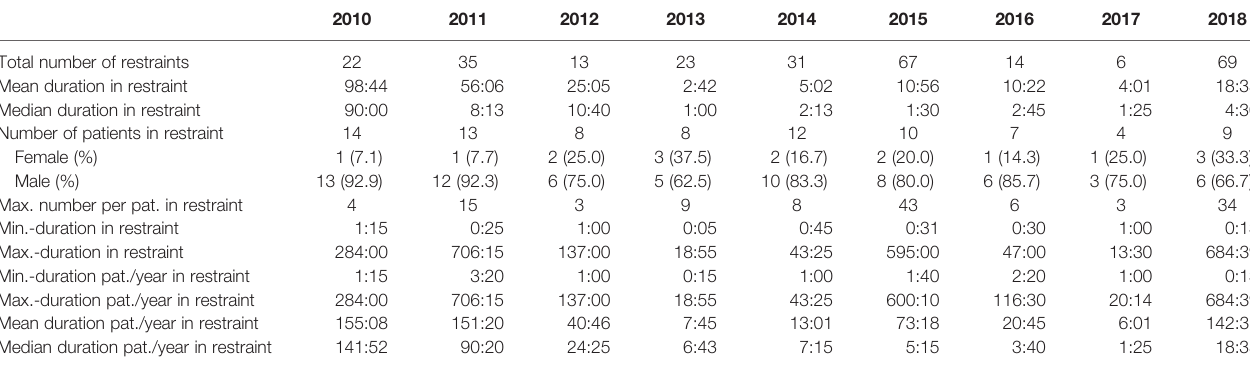
Durations are reported in the format hhh:mm.